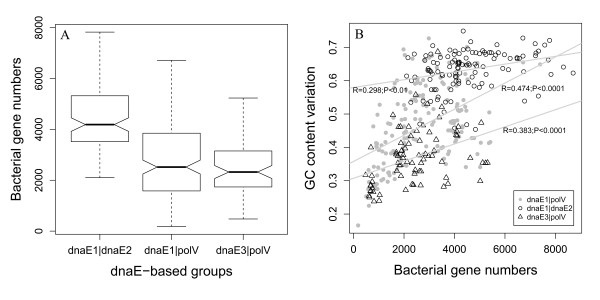
Gene numbers across the dnaE-based groups. The box-plots show gene numbers (A) and the correlation between gene number and GC content variation (B) across the dnaE-based groups.